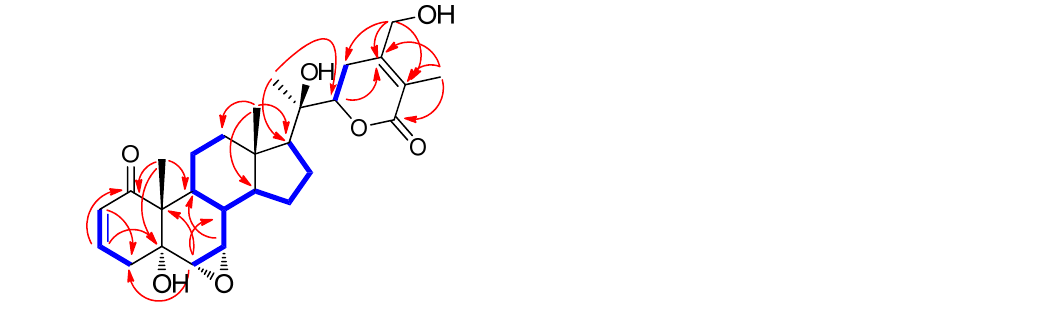
Figure 2. Key 1 H- 1 H correlation spectroscopy ( 1 H- 1 H COSY) ( ) and heteronuclear multiple bond correlation (HMBC) ( ) correlations for 1 .